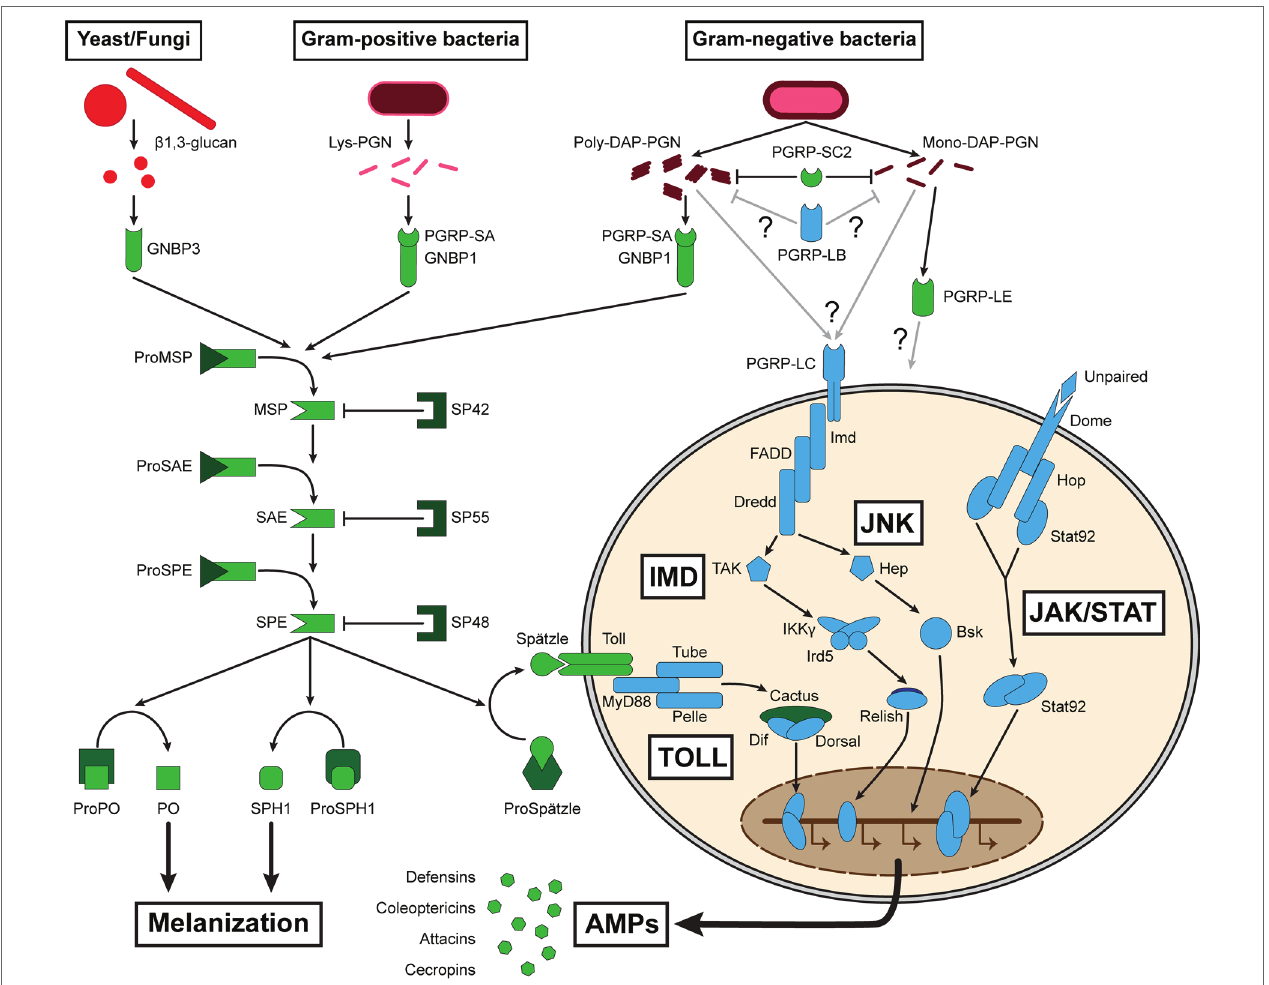
FIGURE 1 | Summary of the major pathways constituting T. molitor humoral immune response. Proteins that have been functionally investigated are represented in green, while proteins evidenced at the genomic and/or transcriptomic levels are represented in blue. Lys: lysine; DAP: diaminopimelic acid; PGN: peptidoglycan; PGRP: peptidoglycan recognition protein; GNBP: Gram-negative binding protein; MSP: modular serine protease; SAE: Spätzle-processing enzyme-activating enzyme; SPE: Spätzle-processing enzyme; SP: serine protease; PO: phenoloxidase; MyD88: myeloid differentiation primary response 88; Dif: dorsal-related immunity factor; Imd: immune deficiency; FADD: Fas-associated death domain ortholog; Dredd: death-related ced-3/Nedd2-like protein; TAK: TGF- β activated kinase; IKK γ : inhibitor of nuclear factor- κ B kinase subunit gamma, also known as Kenny; Ird5: immune response deficient 5; Hep: hemipterous; Bsk: basket; Dome: domeless; Hop: hopscotch, also known as Jak: Janus kinase; Stat: signal transducer and activator of transcription; AMP: antimicrobial peptide; JNK: c-Jun N-terminal